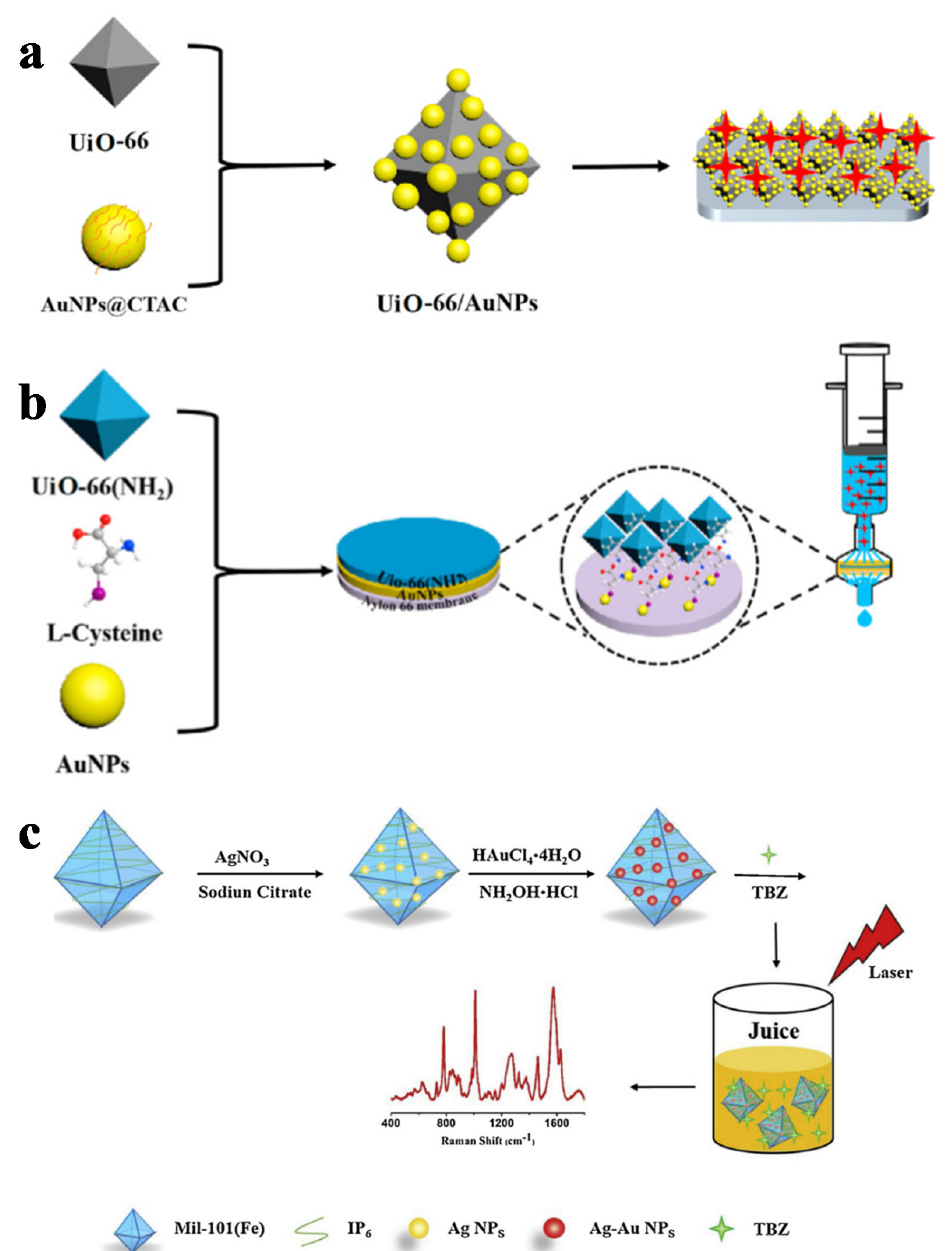
Figure 6. ( a ) UiO-66/AuNPs [96] ( b ) UiO-66(NH 2 )/AuNPs/Nylon-66 [96] ( c ) Preparation of Ag-Au- IP 6 -MIL-101 (Fe) and SERS determination of TBZ in fruit juice [97]. Similarly, Xu et al. [97] prepared Ag-Au-IP 6 -MIL-101 (Fe) (Figure 6c) in situ on the MOF surface. Some target molecules containing N or S atoms can approach the surface of Au-IP6-MIL-101 (Fe) substrate through strong interaction with Fe 3+ , thus improving the detection sensitivity of SERS. The rapid detection of thiabendazole in fruit juice has a good